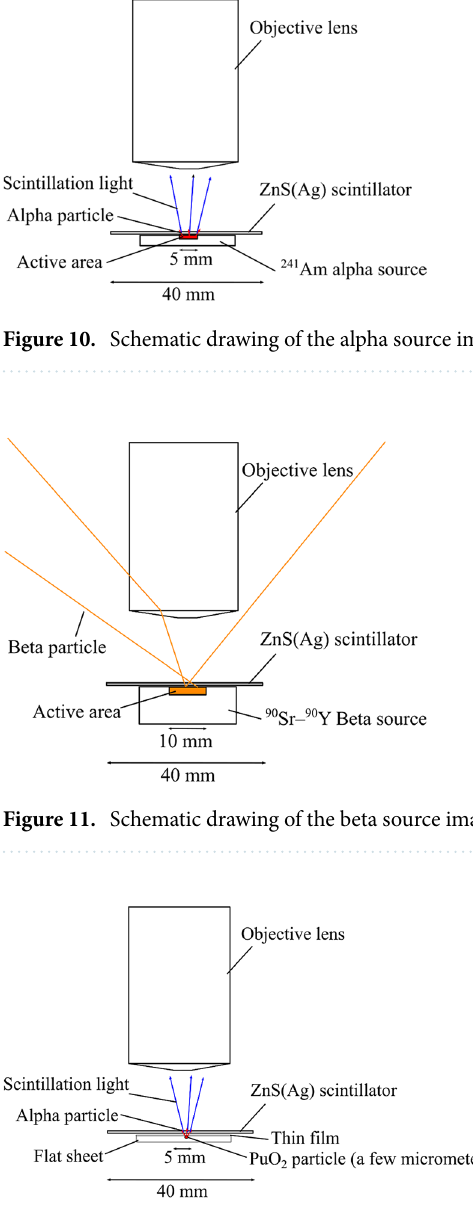
Figure 12. Schematic drawing of the PuO 2 particle